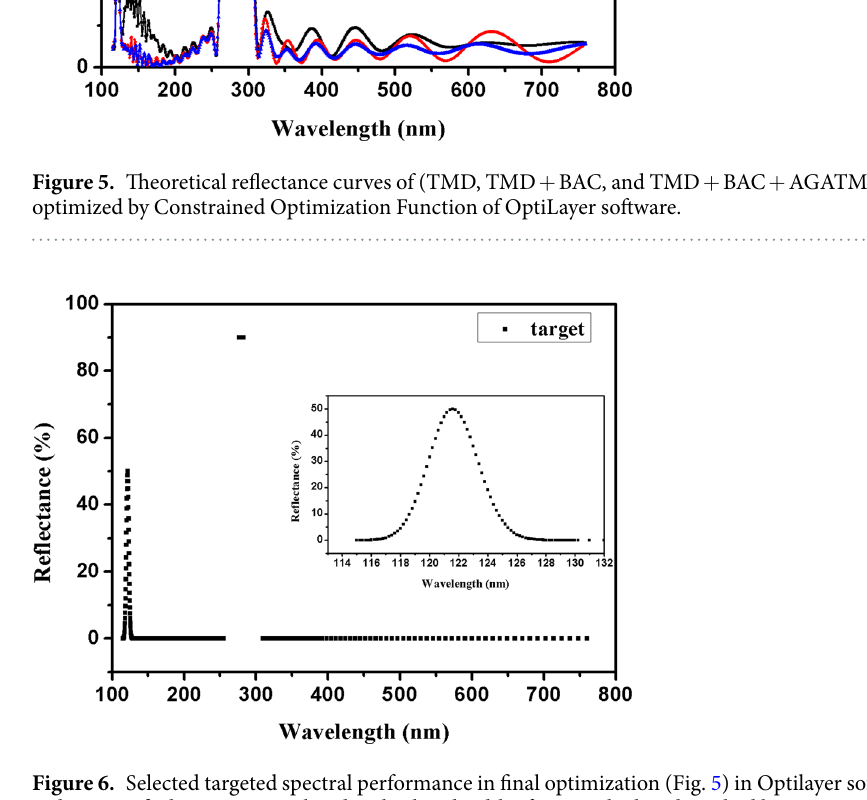
is applied to reduce oscillations in the passband of 121.6 nm stopband. Then, AGATMD is utilized to suppress sidelobe ripples of 280 nm reflection zone. Finally, Constrained Optimization Function of OptiLayer software is employed to further optimize multilayer, and Gaussian type of target curve for 121.6 nm stopband benefits the achievement of a narrow bandwidth of 4 nm. Compared with Narukage’s job, our designed cold mirror has a narrower bandwidth at 121.6 nm stopband, and lower sidelobe ripples, and its shortcoming is that the reflectance at 121.6 nm is not high. We utilize only one kind of LaF 3 /MgF 2 multilayer to achieve targeted spectral response that Narukage employed two kinds of multilayers (LaF 3 /MgF 2 + SiO 2 /HfO 2 ) to realize, our designed multilayer structure is simpler, and easier to be deposited, the spectral performance is also good. Our designed dual-band mirror will contribute most to study magnetic structure of solar chromosphere.